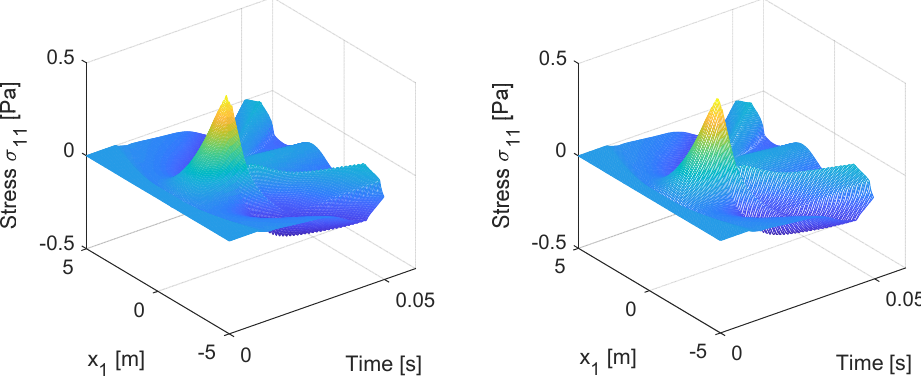
Figure 7. Time history of u 1 at x 3 = − 1 generated by the analytical solution (left) and the SBM-EWM (right). Figure 8. Time history of σ 11 at x 3 = − 2 generated by the analytical solution (left) and the SBM-EWM (right).